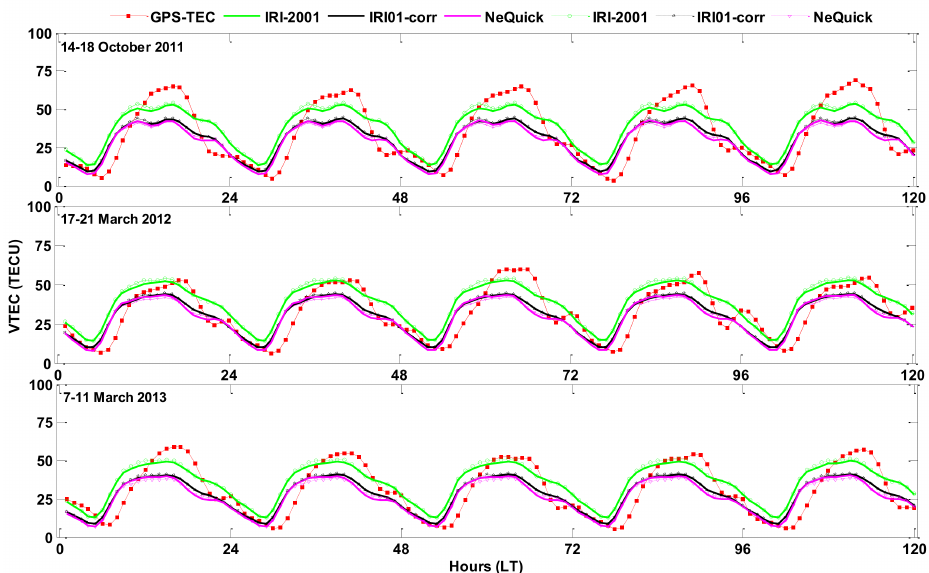
Figure 4. The daily variation of the measured and modelled VTEC during the quiet periods. The IRI-2016 (IRI-2001, IRI01-corr, and NeQuick) are plotted in solid lines and the IRI-2012 (IRI-2001, IRI01-corr, and NeQuick) are plotted in dotted